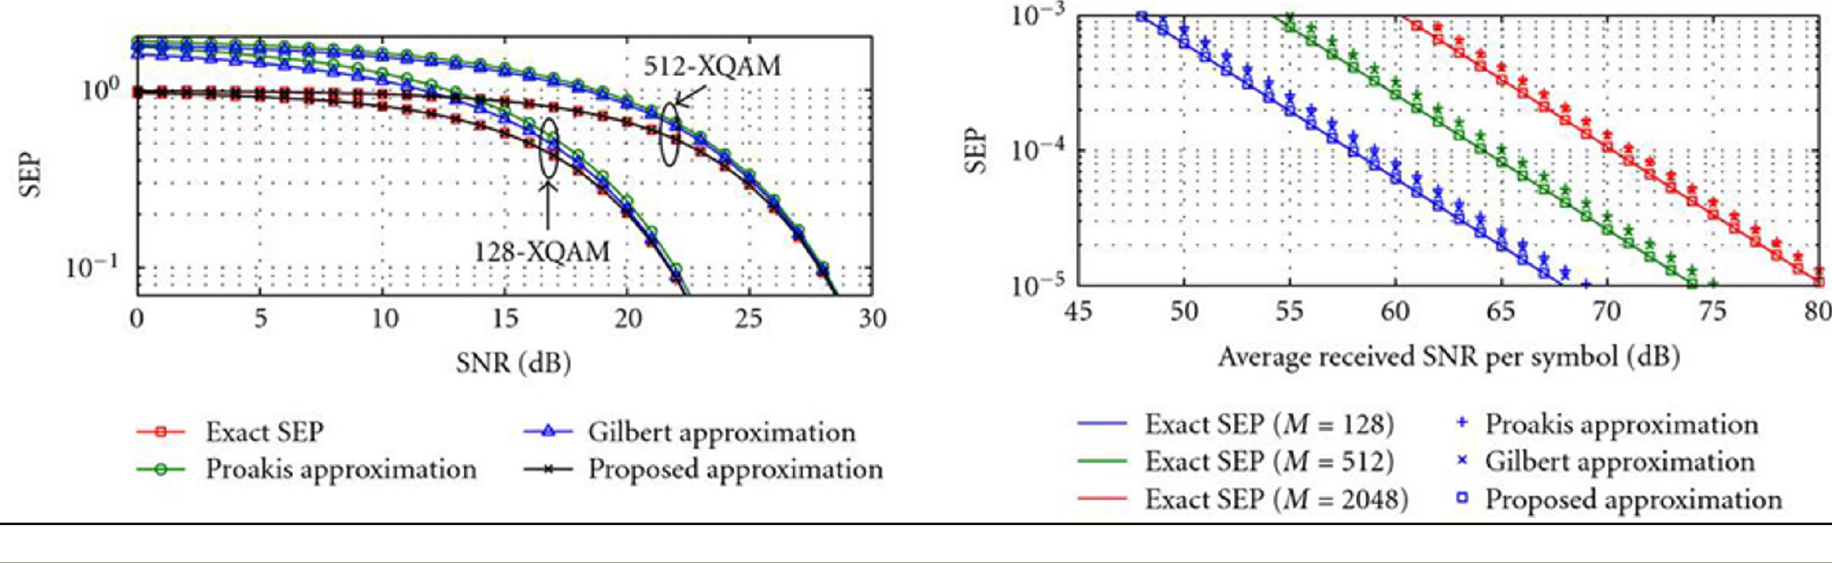
Figure 4 Comparison of the exact and approximate SEP expressions for cross -QAMs. Note